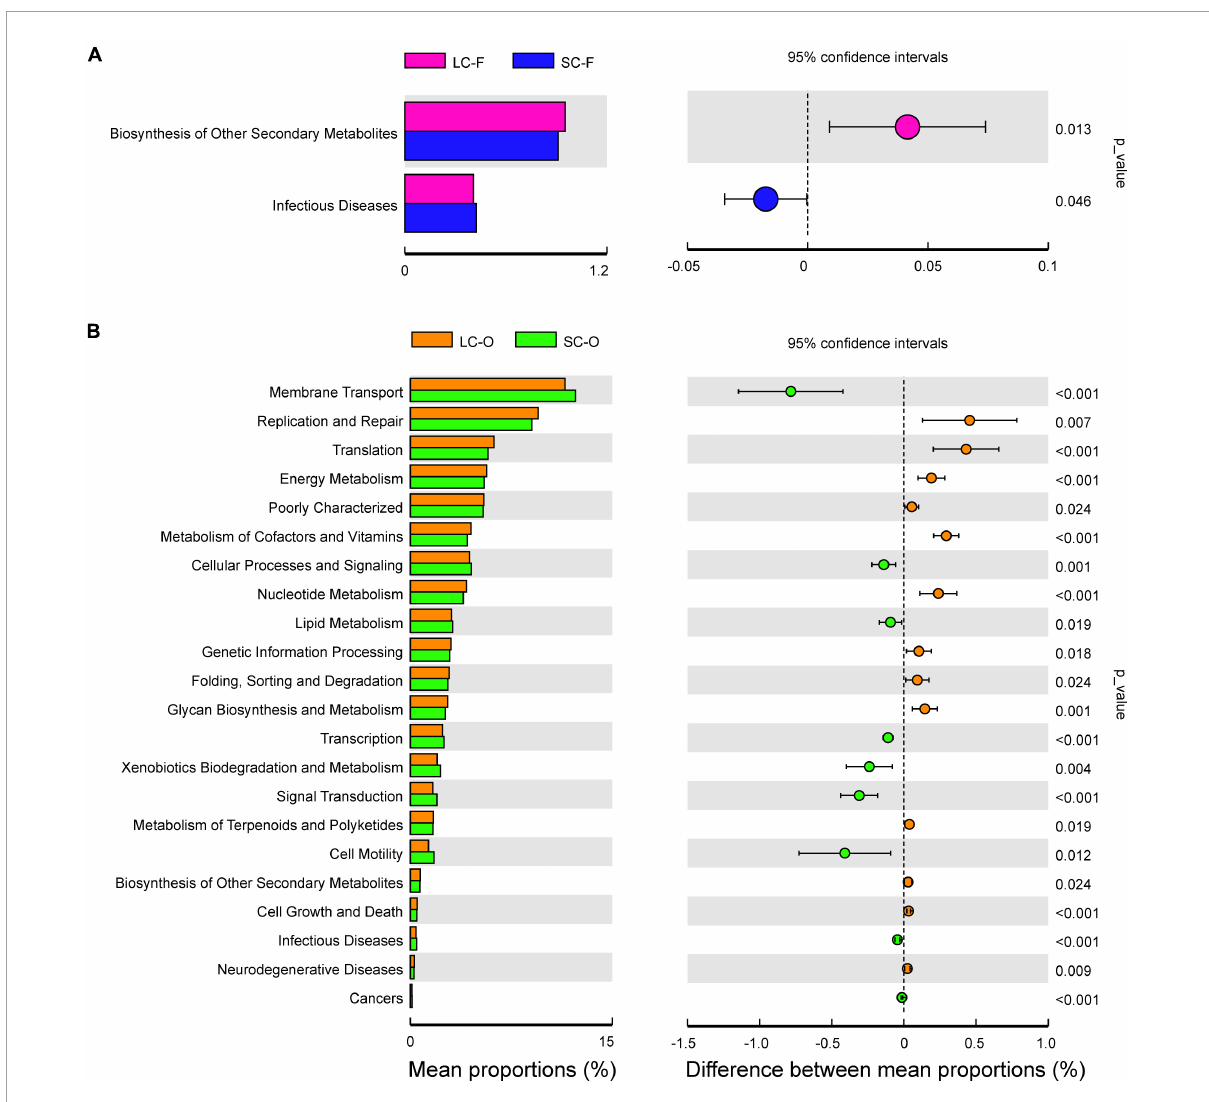
FIGURE6 Phylogenetic Investigation of Communities by Reconstruction of Unobserved States (PICRUSt) analysis of the Kyoto Encyclopedia of Genes and Genomes (KEGG) metabolic pathways in the second level showed the significant differential functions of fecal (A) and oral microbiome (B) between long-term captivity (LC) and short-term captivity (SC) groups (tested by multiple t